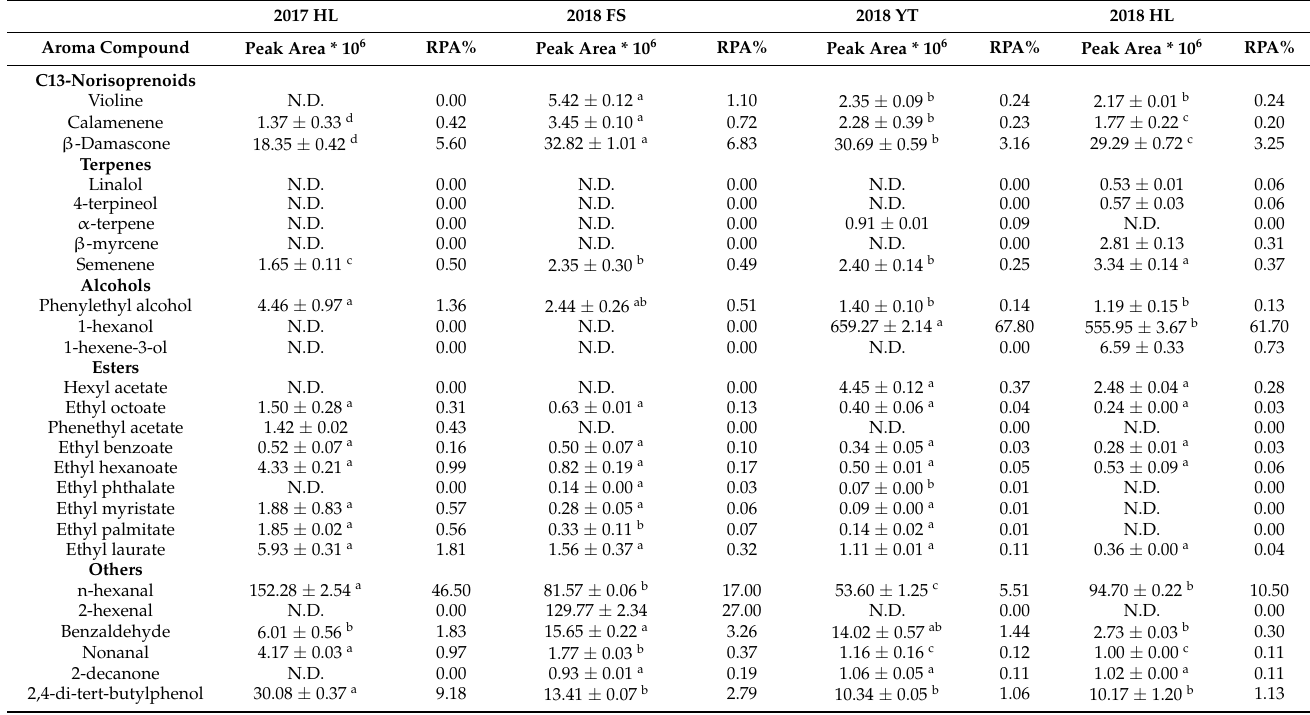
Table 3. The average peak area and relative peak area (RPA) of volatile aroma compounds of Marselan